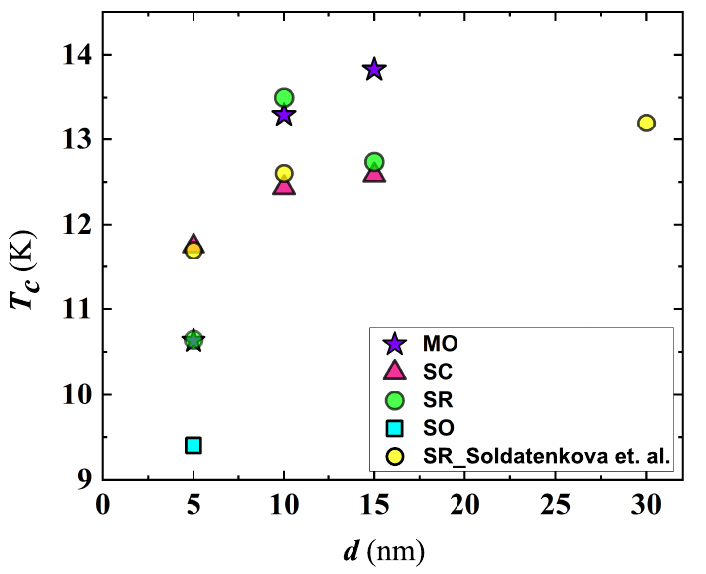
Figure 2. Thickness dependence of the superconducting transition temperature of NbN films de- posited on MgO (MO), SiO 2 (SO) and Al 2 O 3 substrates, both c-cut (SC) and r-cut (SR) types. For com- parison, T c data of films deposited on Al 2 O 3 r-cut substrates by Soldatenkova et al. [37] were